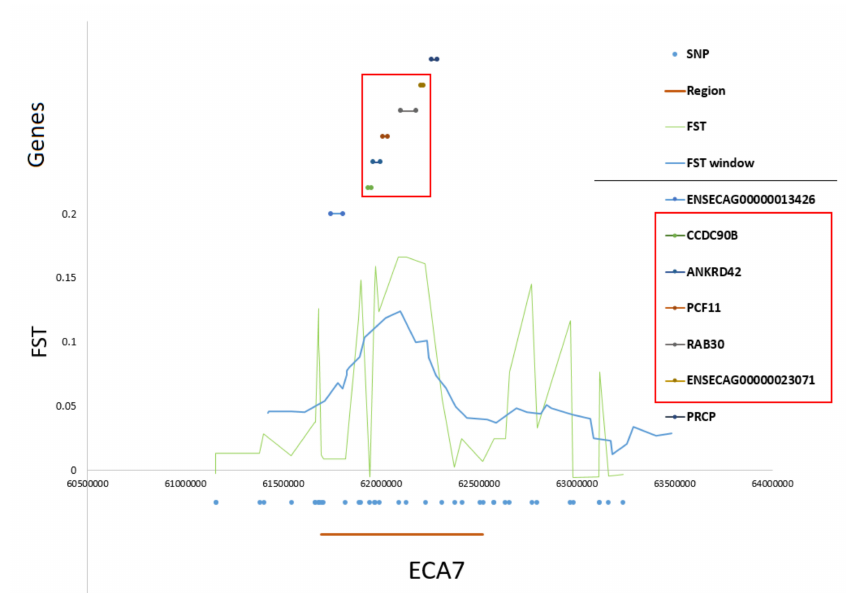
Figure 7. Detailed view of the divergently-selected region on ECA7. Region position, SNP positions, F ST and window-averaged F ST values, and gene positions directly at the selected region are plotted.